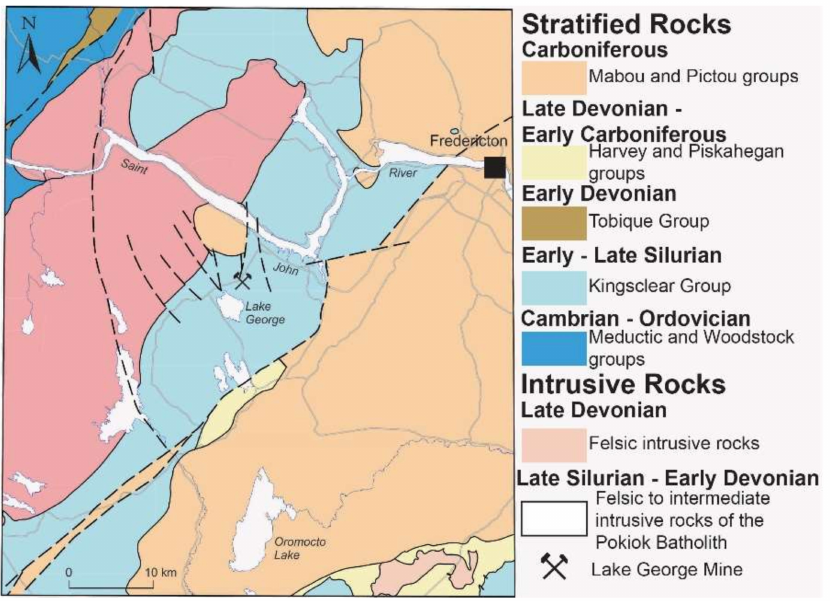
Figure 1. Geological map of the Lake George area and surrounding region in central New